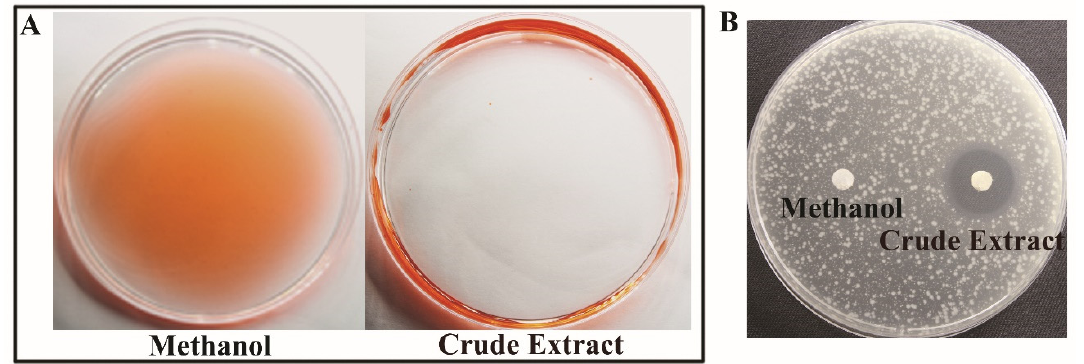
Figure 1. Analysis of the bio-surfactant activity prepared from P. protegens Pf-5. ( A ) Antibacterial activity; ( B ) Crude extract from P. protegens Pf-5. The crude extract was directly